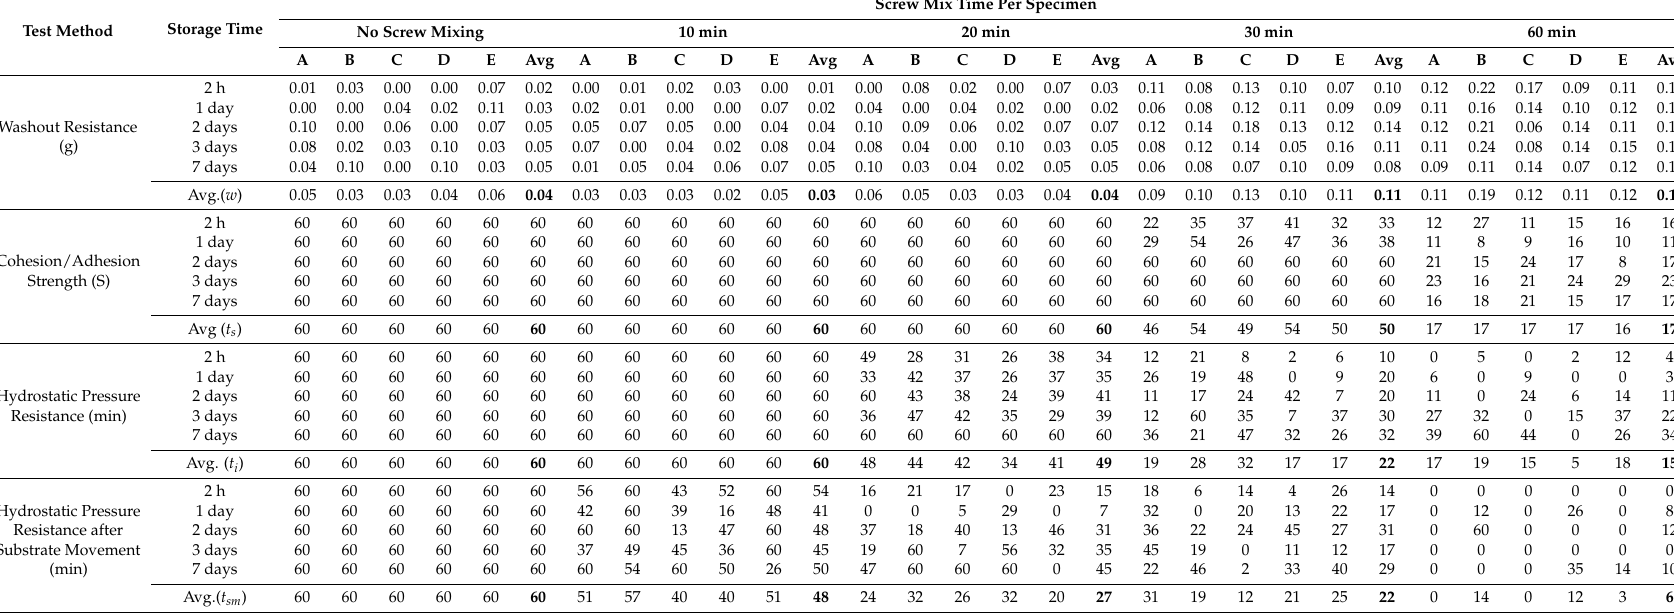
Table 6. Waterproofing performance testing results based on different screw-mixing times over predetermined storage